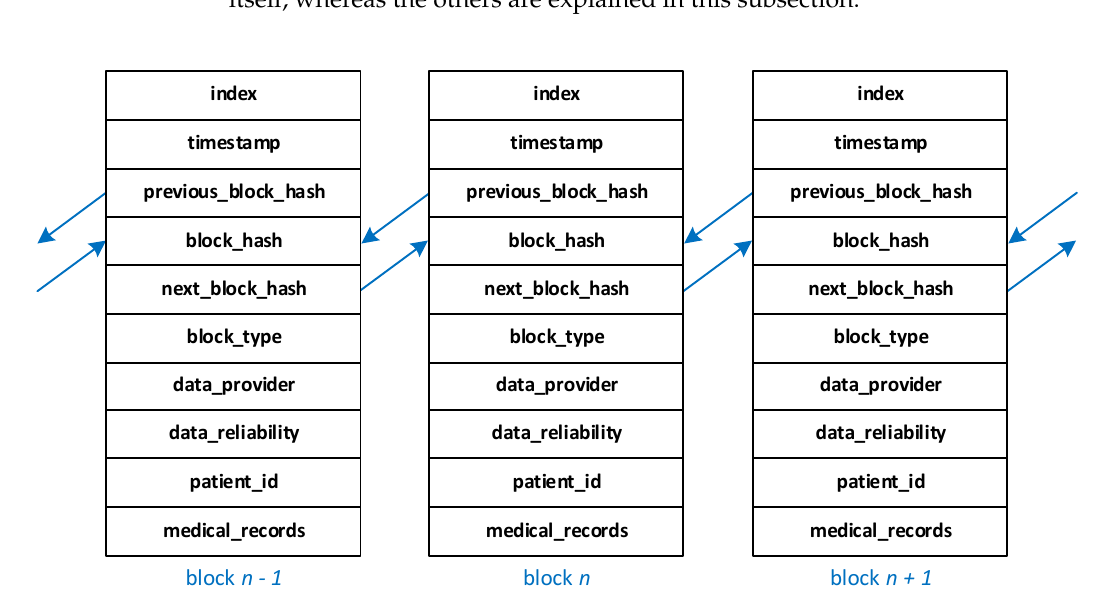
Figure 4. The proposed structure of the blockchain.